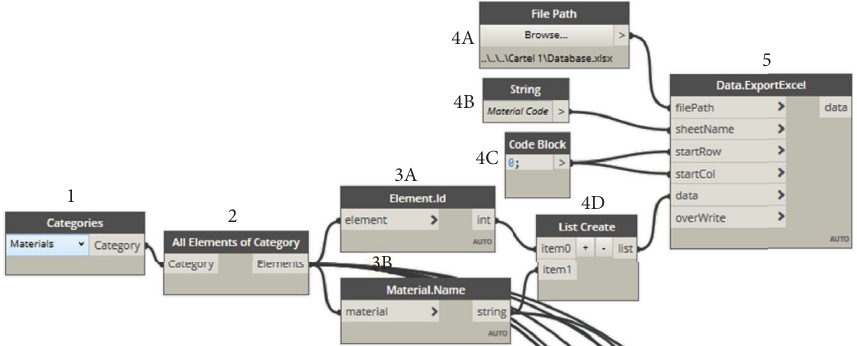
Figure 8: Exporting materials’ codes to